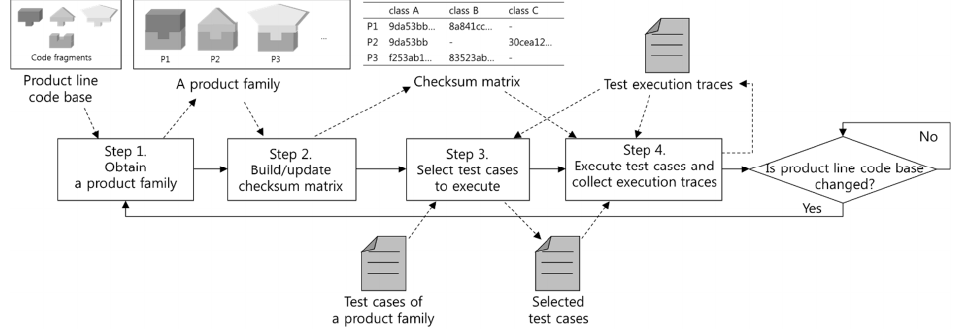
Figure 2. The process for avoiding equivalent test